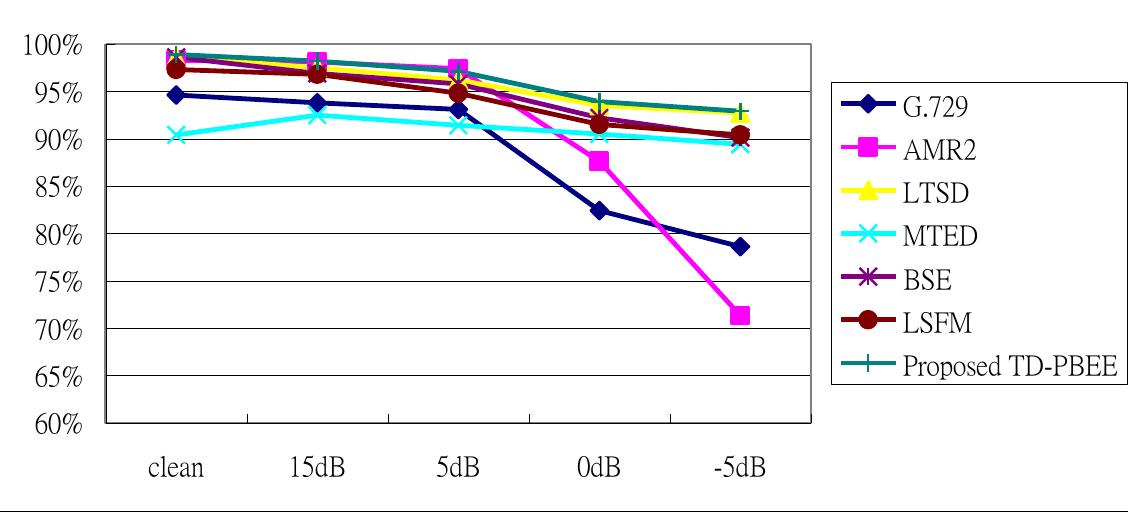
Figure 10. Speech hit rate (HR1) from clean to 5 dB under the four types of